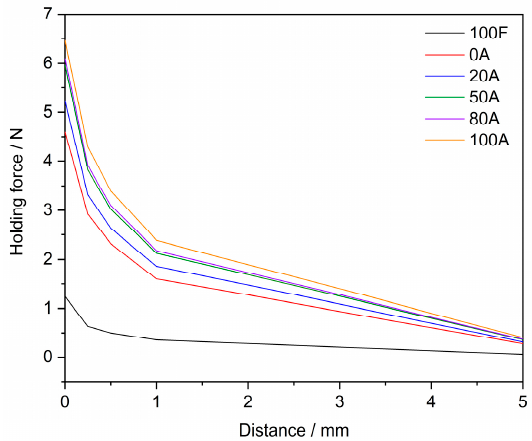
Figure 12. The calculated magnitudes of holding forces acting on the plastic plate. As reported in Figure 12, simulated holding forces calculated for different variants of magnetic filling of the plastic plate were, as expected, found to increase with higher infill density with determined values in the range from 4.5 to 6.5 N at zero distance. Such forces are sufficient to ensure a stable attachment of smaller or lighter objects. Thus, the prepared materials can produce components designed to conduct a magnetic flux or a small force interaction and thus attach a certain object. In practice, such elements can then be used in the construction of magnetic switches or sensors or for the production of com- ponents that homogenize the magnetic field of electric motors. 4. Conclusions This work focused on determining the magnetic properties of PET-G containing mag- netic additive based on Iron(III) and Titanium(II) oxides. The thermal analysis measure- ments were performed to characterize the thermal behavior of applied polyethylene- based filaments and to determine the correct set-up of processing temperatures. The prod- ucts with different infill densities, and thus various internal architectures, were produced using Fused Filament Fabrication technology.